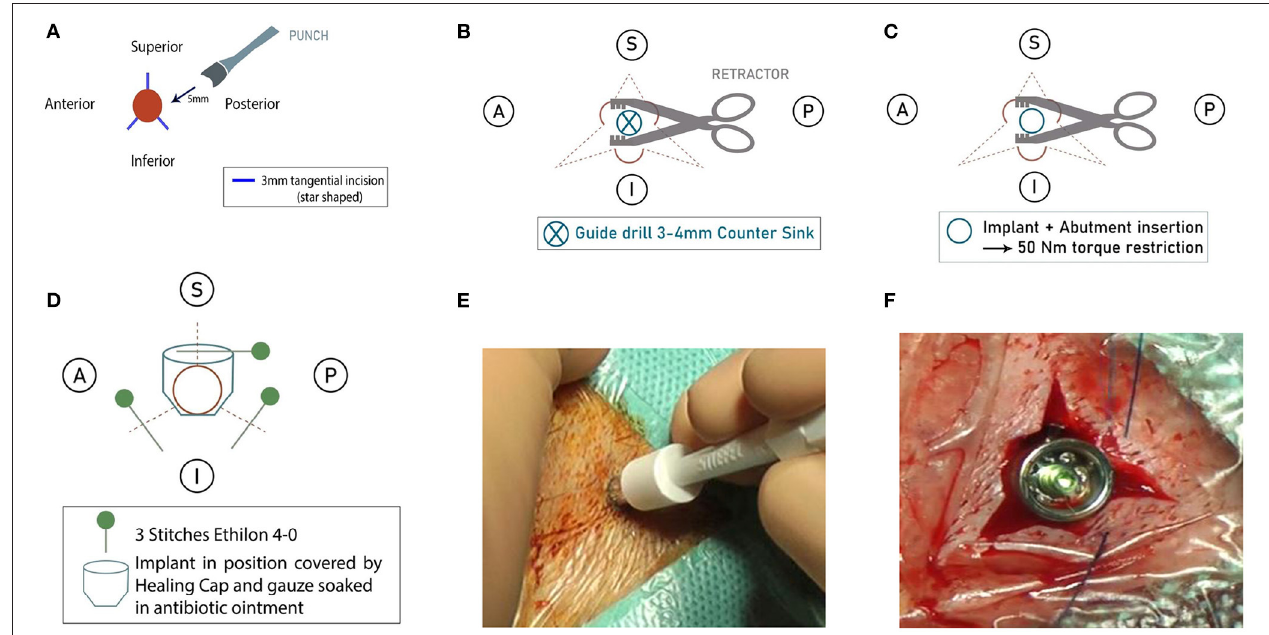
FIGURE 1 | (A) Step 1: A punch followed by three perpendicular incisions. (B) Step 2: Use of retractors to expose the bone (an implant site). (C) Step 3: Drilling and placement of implant and attached abutment. (D) Step 4: Closing of incisions, antibiotic wound dressing with a healing cap. (E) Image: Punch incision on the preoperative drawn position. (F) Image: Perpendicular incisions closed with three cutaneous stitches (Ethilon